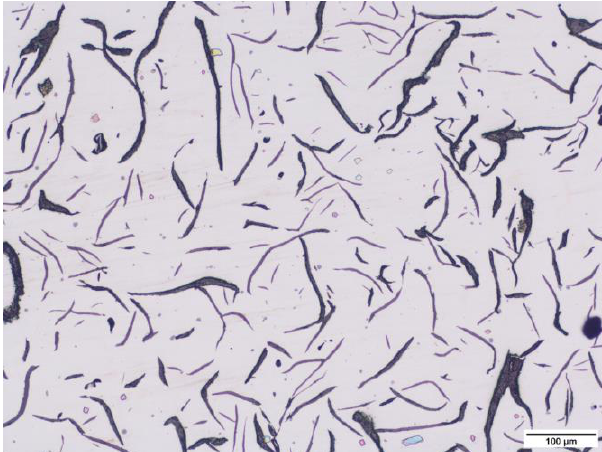
Fig. 9. Magnified image of the microstructure shown in Fig. 8; visible Fig. 7. Magnified image of the material structure of the analyzed brake flakes of graphite on the background of perlite matrix; precipitations of disc shown in Fig. 6; visible flake inclusions of unmodified graphite; phosphorus eutectic and manganese sulfides are also observed locally; unetched state, light microscopy light microscopy, etched with HNO